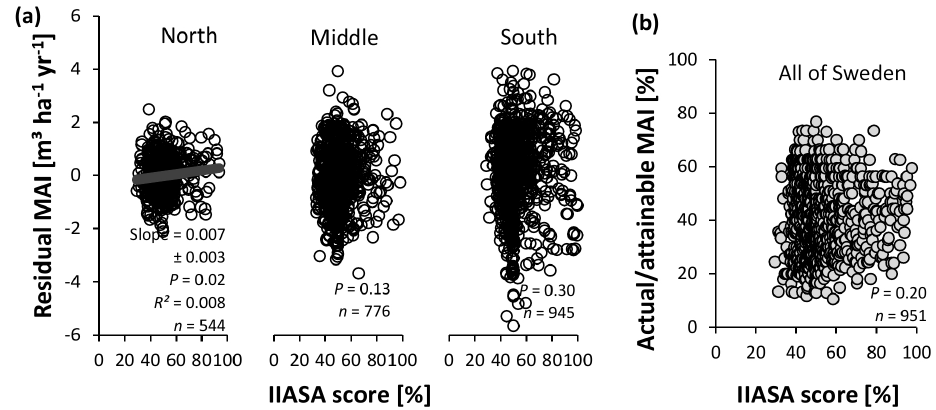
Figure 9. Evaluation of the IIASA metric of constraints on nutrient availability for Swedish conifer forests. (a) Method 1 – association with residual mean annual increments (MAIs) of the productivity–climate regression model (Fig. 3a, Eq. S1 and Table S2), distinguishing northern, middle, and southern Sweden. (b) Method 2 – association with actual / attainable MAI for the entire Swedish land area (Fig. 3b). Full line: significant slope ( P <0.05).